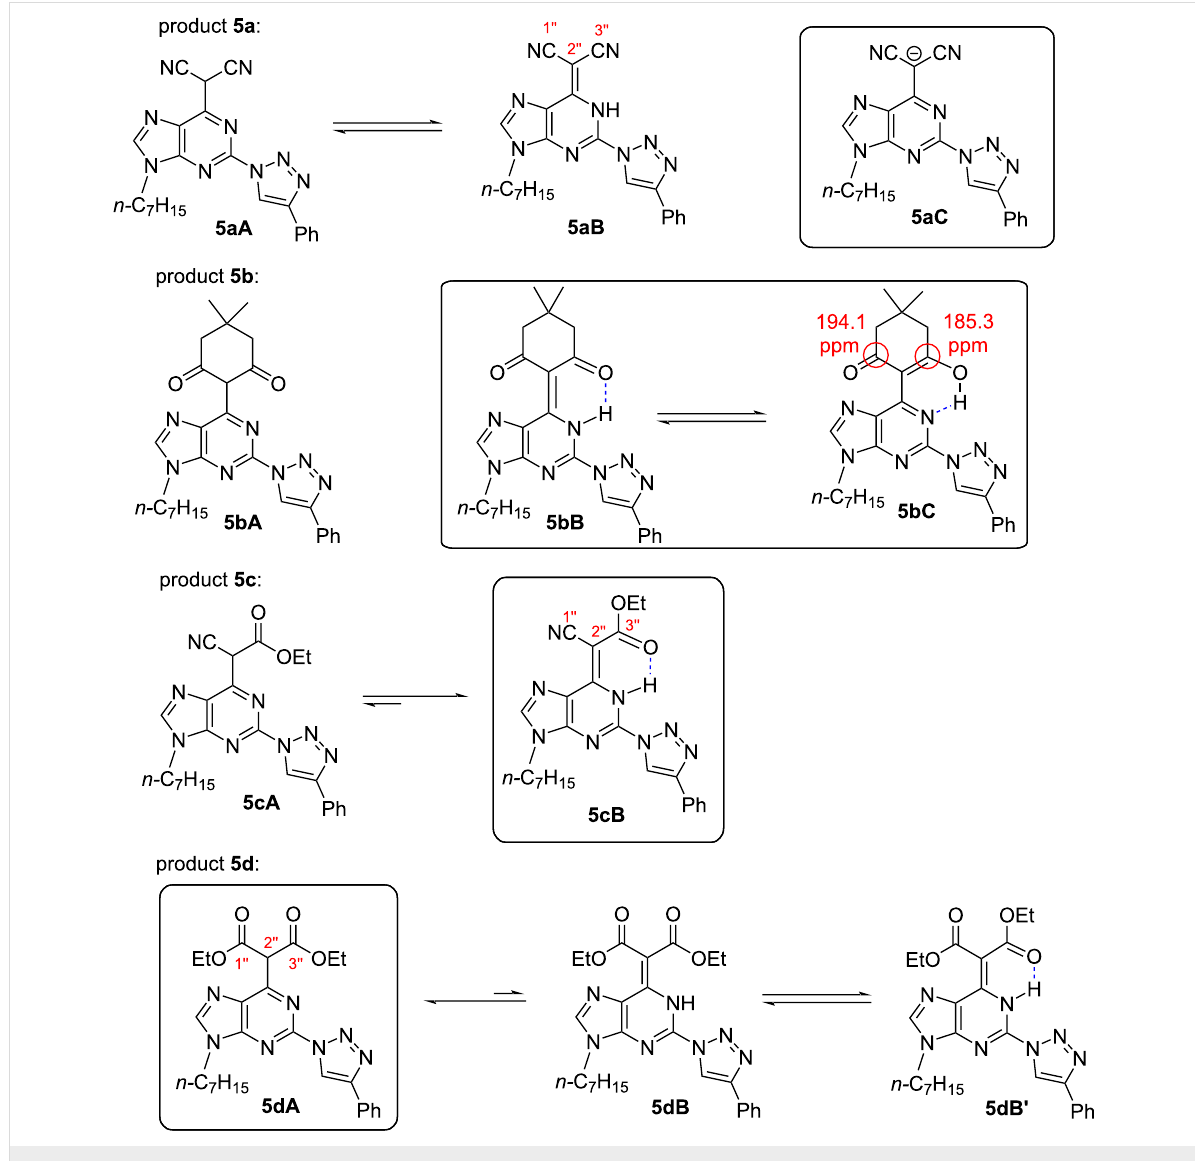
Figure 1: Possible tautomeric structures of compounds 5a–d